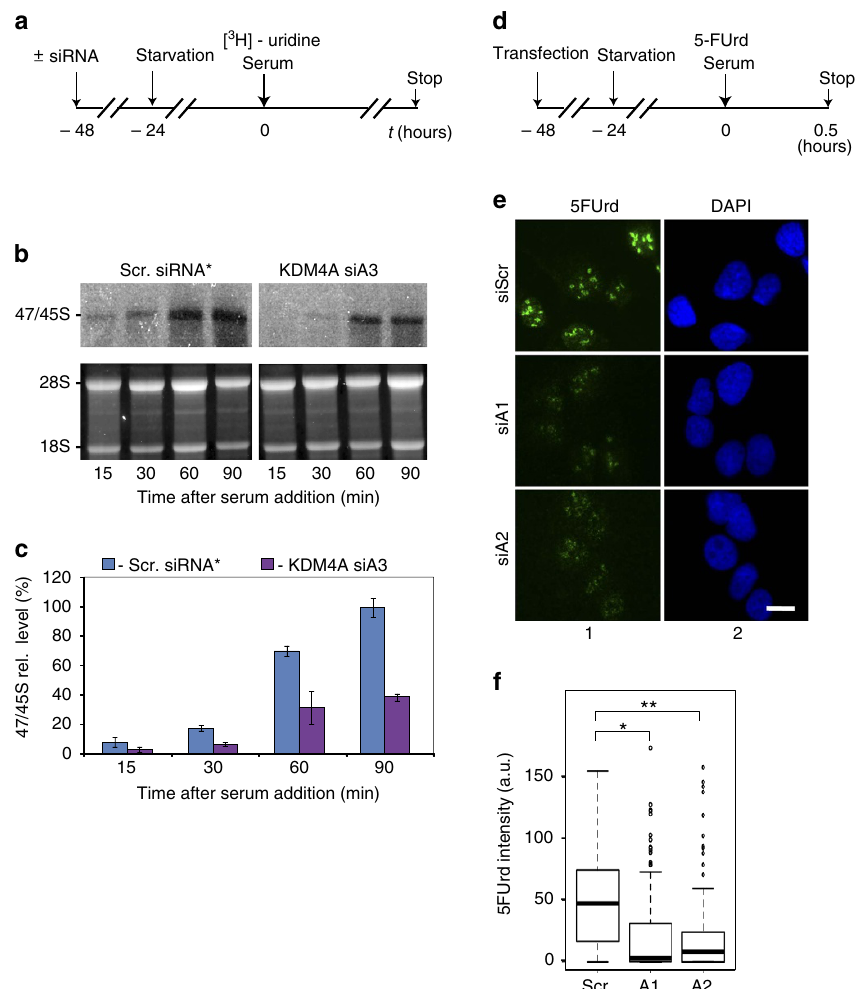
Figure 3 | KDM4A is important for serum-induced rRNA synthesis. ( a ) Schematic representation of the labelling of cells with 3 H-uridine to determine the effect of KDM4A depletion on activation of rRNA synthesis. U2OS cells were transfected either with non-targeting (siScr) or KDM4A-specific siRNA3 (siA3). 24h post-transfection cells were starved. Transcription was activated by addition of serum and 3 H-uridine at time point 0. ( b ) RNA was extracted 15, 30, 60 and 90min after serum addition and de nov o rRNA transcripts were detected by tritium imaging of RNA blots (top panel) using X-ray film. Total 18S and 28S rRNAs were detected by ethidium bromide staining (bottom panel). ( c ) To determine the relative efficiencies of rRNA synthesis, RNA blots were imaged using tritium image plate (Fuji) and quantitated with aid of phosphoimager (Fuji) and Aida software (Raytec). Transcript levels are indicated for 47S/45S pre-rRNA. The data are expressed as a percentage of the highest value (set at 100%). The s.d.’s for three independent experiments are shown; n ¼ 3. ( d ). Schematic representation of the labelling of cells with 5-FUrd to determine the effect of KDM4A depletion on activation of rRNA synthesis in individual cells. U2OS cells were serum-starved for 16h, electroporated with either a non-targeting siRNA (siScr) or two siRNAs directed against KDM4A (siA1 and siA2) and kept in serum-free medium for further 24h before serum refeeding in the presence of 5-FUrd for 30min. ( e ). Cells were stained for 5-FUrd incorporation using anti-BrdU antibodies. Nuclear DNA was stained with DAPI. Representative immunofluorescence images are shown. Scale bar, 5 m M. ( f ). Quantification of 5-FUrd staining shown in e , done as in Fig. 2e; P value (Wilcoxon test) ¼ * 4.84 (cid:2) 10 (cid:3) 11 , ** 6.12 (cid:2) 10 (cid:3) 12 . Note the presence of many outliers in samples transfected by KDM4A siRNA, which most likely correspond to untransfected cells. The median values are shown as horizontal lines, outliers are shown as open circles; n ¼